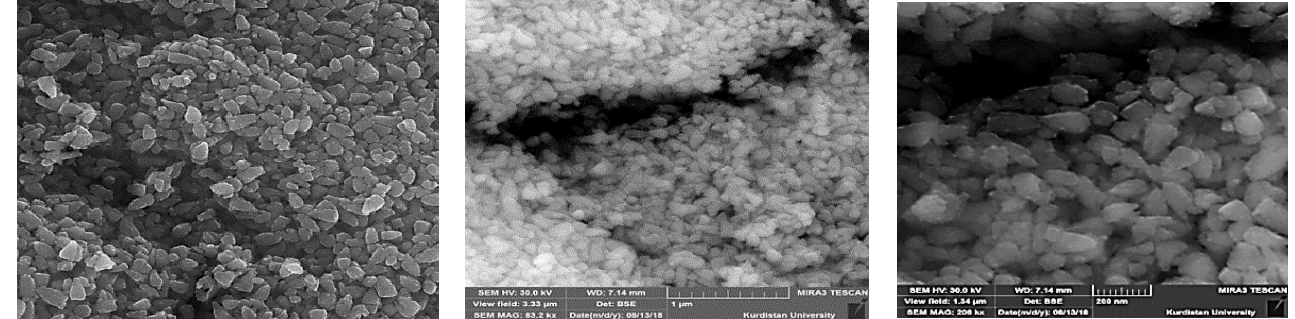
Int. J. Mol. Sci. 2021 , 22 , x FOR PEER REVIEW Figure 3. Scanning electron microscope (SEM) image of green synthesized ZnO-NPs.